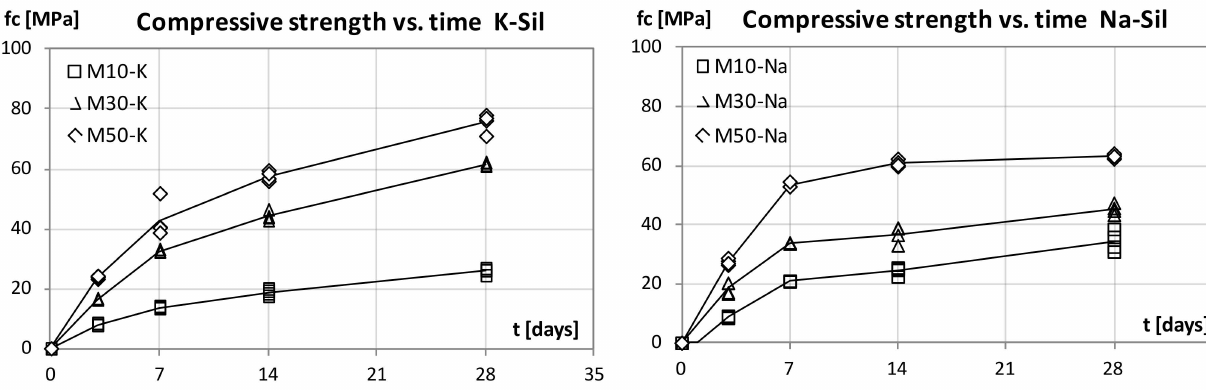
Figure 2. Compressive strength development with curing time, K-Sil and